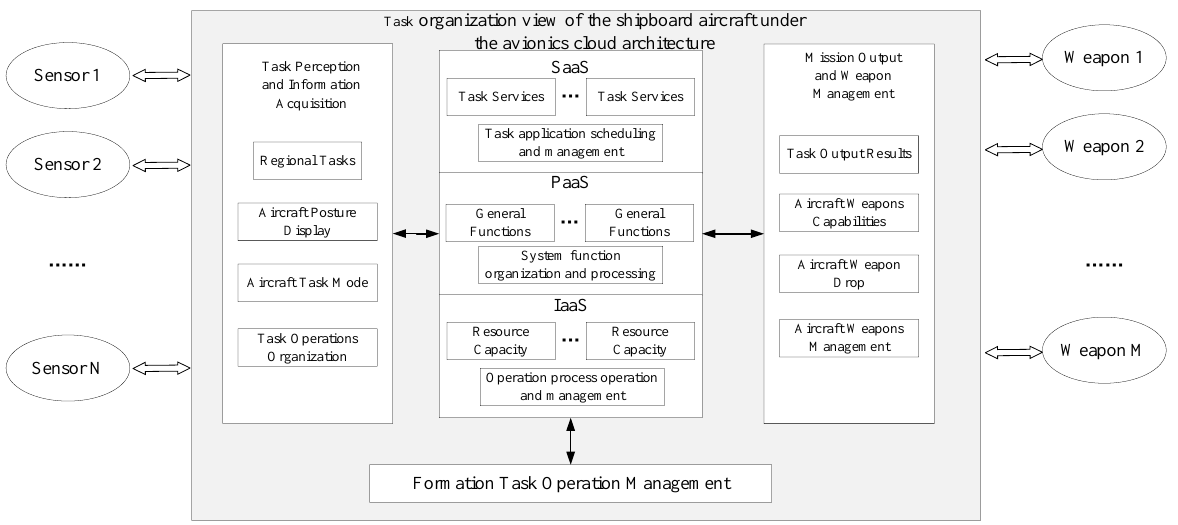
Figure 3. Task organization view of the shipboard aircraft under the Avionics Cloud architecture.